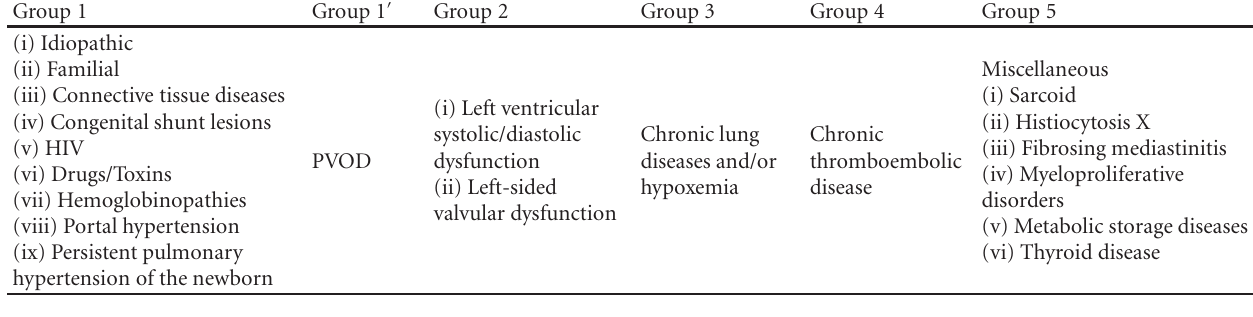
Table 1: Classification system of pulmonary hypertension into groups 1–5 based on underlying disease process.